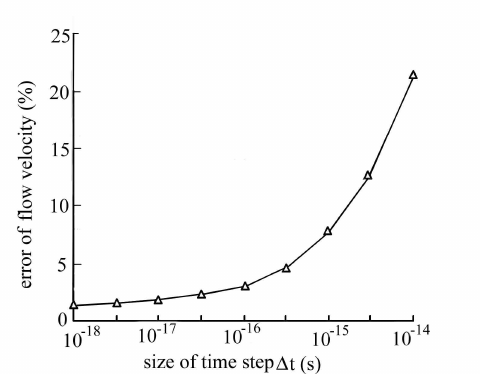
Figure 7 . Illustration of the relationship between the error of the maximal flow velocity and the size of the time step (LA